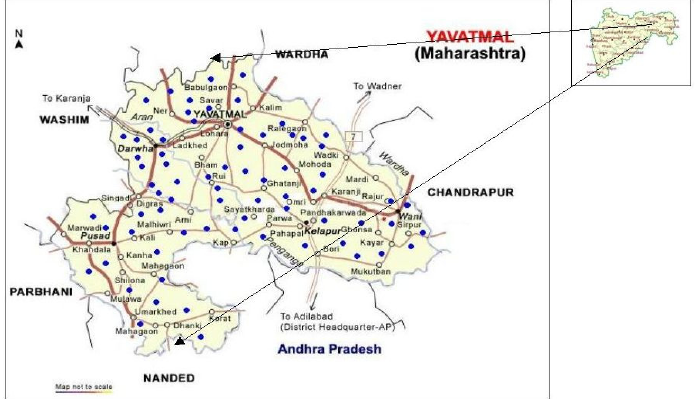
Figure 1. Sampling locations (blue points) in Yavatmal